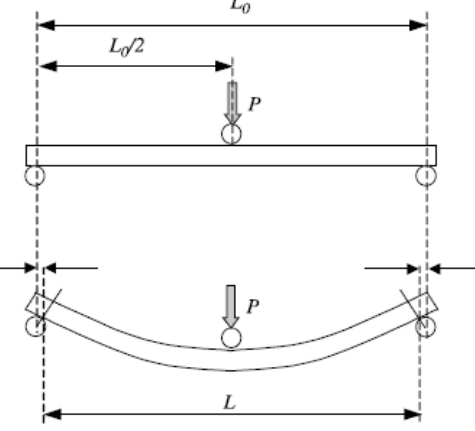
Fig. 4. Effect of deflection to the computed